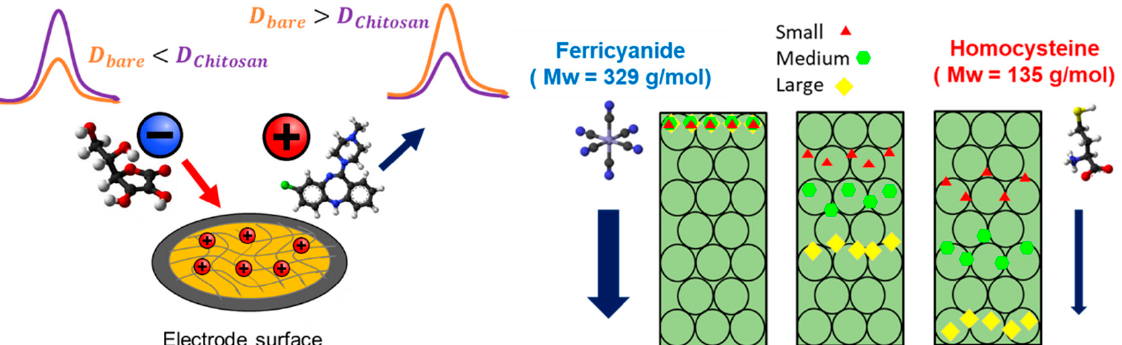
Figure 1. Scheme describing the differentiation of redox molecules by using diffusion-limiting chitosan-modified electrodes. Since the chitosan film is positively charged, the negatively charged redox molecules are electrostatically attracted to the electrode, resulting in faster diffusion rates. Moreover, for chitosan films of higher densities, redox molecules with smaller molecular weights can undergo a longer diffusion path resulting in a slower diffusion rate toward the electrode.